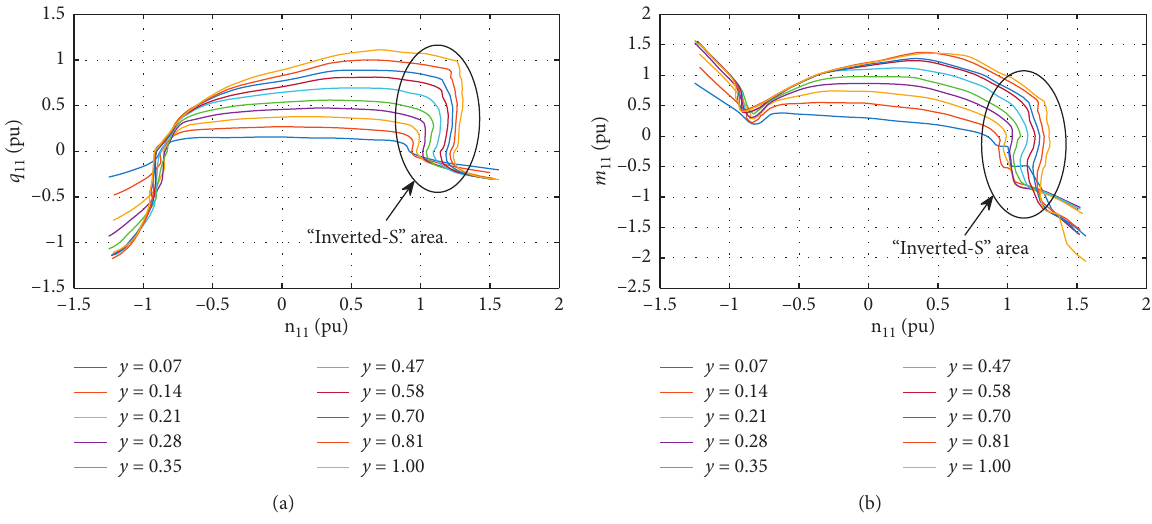
Figure 4: The characteristic curves of a pump-turbine. (a) Flow characteristic curve. (b) Moment characteristic curve.